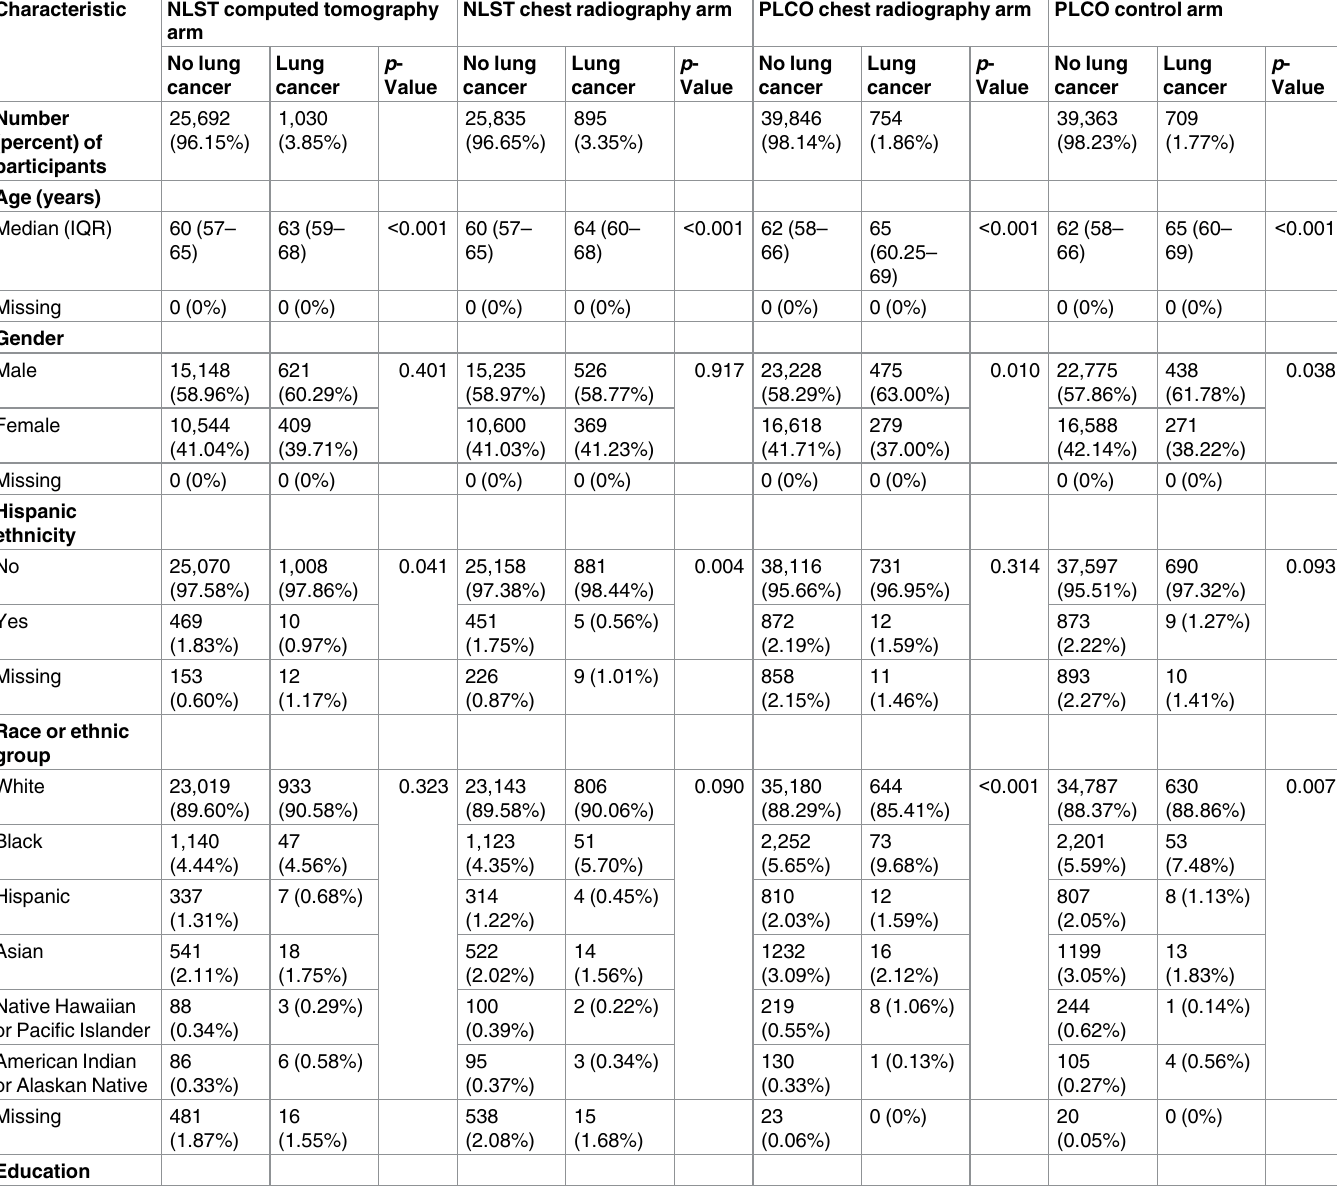
Table 2. Baseline characteristics of National Lung Screening Trial and Prostate, Lung, Colorectal and Ovarian Cancer Screening Trial participants according to 6-y lung cancer